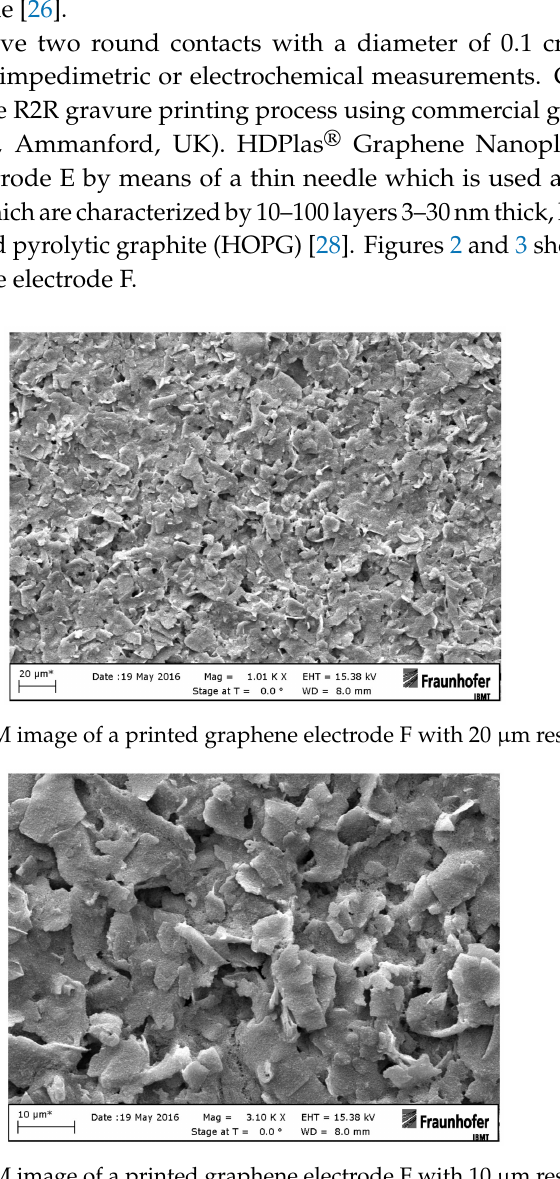
Figure 3. SEM image of a printed graphene electrode F with 10 µ m